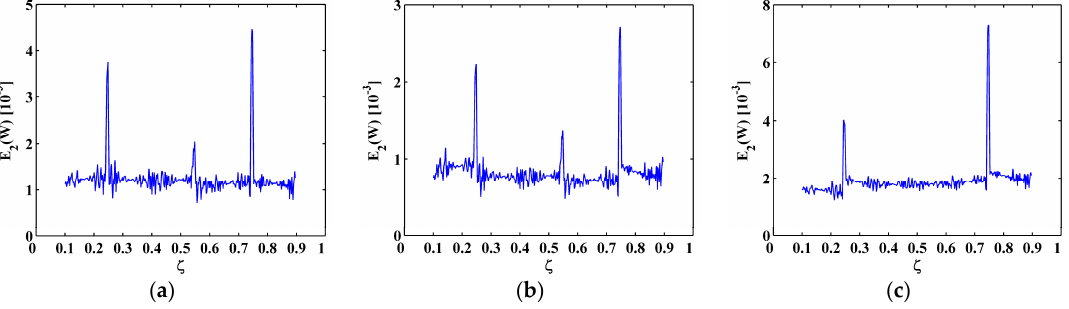
Figure 7. MRM-TKE for the ( a ) sixth; ( b ) seventh; and ( c ) eighth mode shapes with 60 dB SNR.